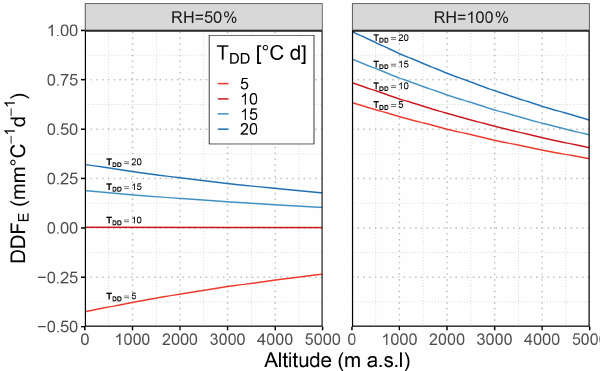
Figure 9. Variation of latent heat component (DDF E ) depending on altitude for different relative humidity values, degree days, and u = 1ms − 1 .